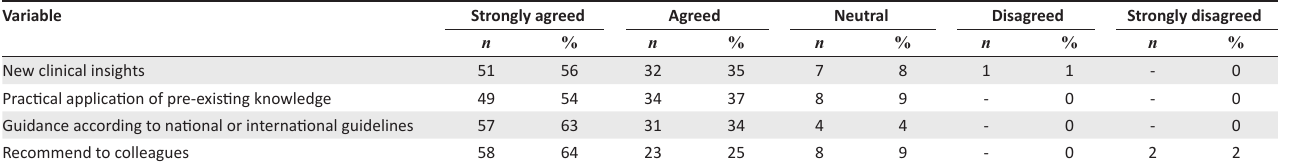
TABLE 1: Usefulness of the group as a learning tool ( n = 91). Variable Strongly